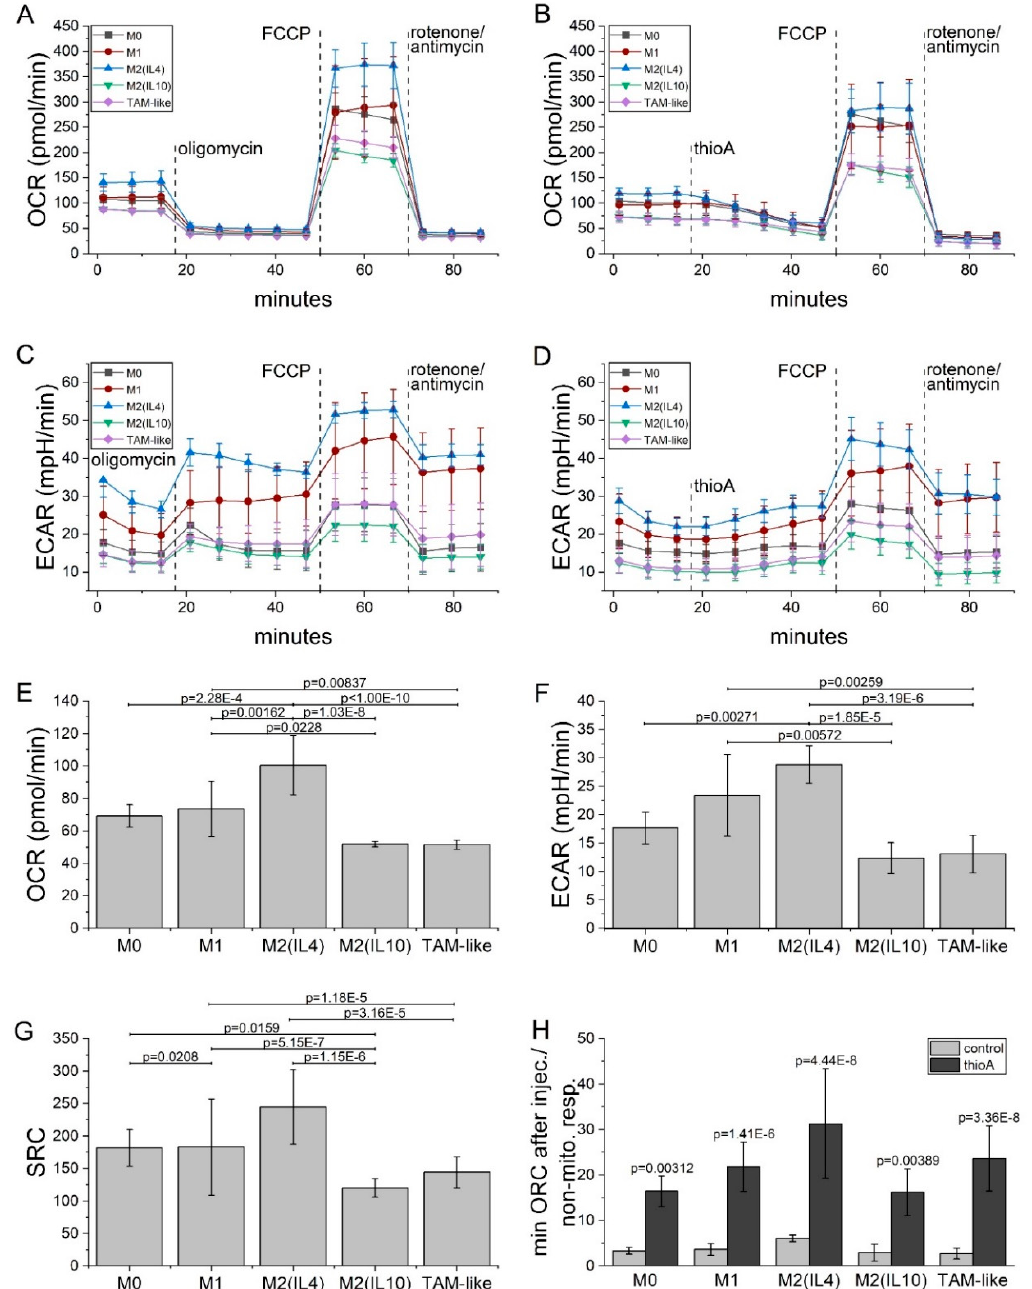
Figure 7. ThioA affects the metabolism of in vitro differentiated and polarized macrophages. Human monocyte-derived macrophages (HMDMs) were polarized into M0, M1, M2(IL4), M2(IL10), and tumor-associated macrophage (TAM)-like macrophages for 24 h. OCR and ECAR were measured in a mito stress test using a Seahorse 96XF instrument. Either 1 µM oligomycin was injected to shut down OXPHOS-dependent ATP production ( A , C ), or 1 µM thioA was injected instead ( B,D ). Basal OCR ( E ), ECAR ( F ), and spare respiratory capacity (SRC) ( G ) were analyzed for the different macrophage subsets in the oligomycin injected setup. Minimal OCR values at the measurement point 5 (47 min) after respective oligomycin or thioA injection were normalized to the non-mitochondrial respiration (last time point after rotenone/antimycin injection) ( H ). Statistical analysis was performed using one-way ANOVA followed by Tukey’s post-hoc analysis. n = 3 (quadruplicates).